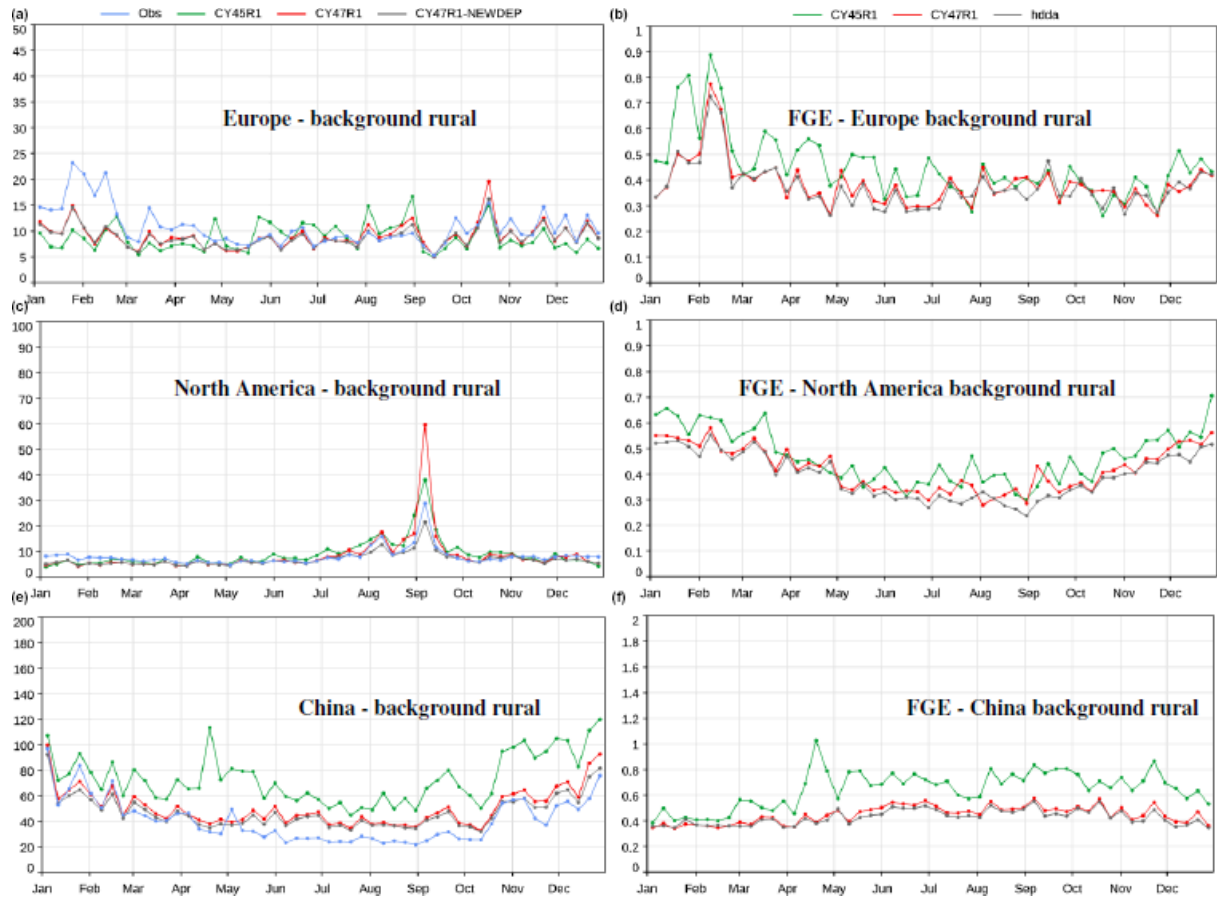
Figure 9. The left column shows observed and simulated weekly PM 2 . 5 over Europe (background rural, a ), North America (background urban, c ) and China (all sites, e ). The right column shows the fractional gross error (FGE) of simulated PM 2 . 5 against